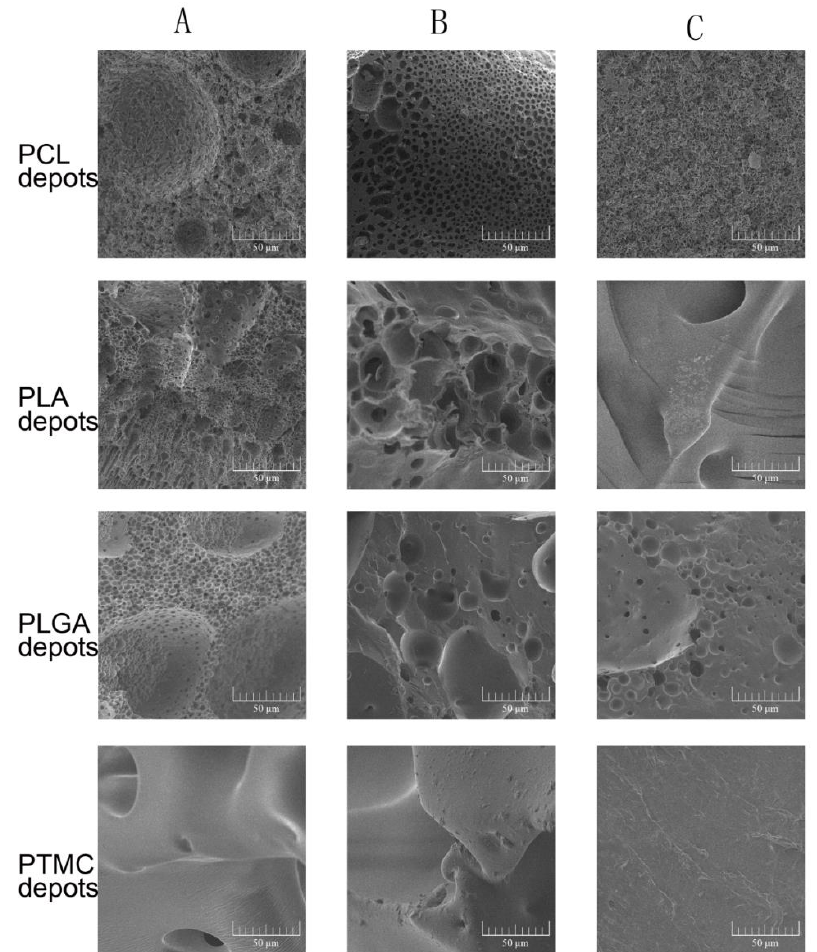
Figure 6. The cross-section morphologies of different ISFI depots examined by scanning electron microscopy. ( A ) ISFI depots prepared by 15% DMSO; ( B ) ISFI depots prepared by 15% NMP; ( C ) ISFI